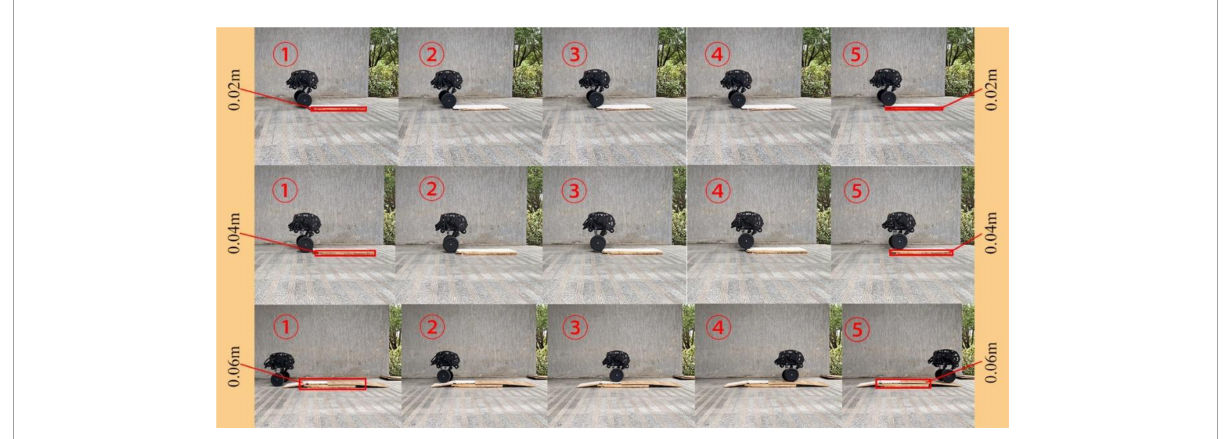
FIGURE23 Comparison of different height of obstacle crossing.